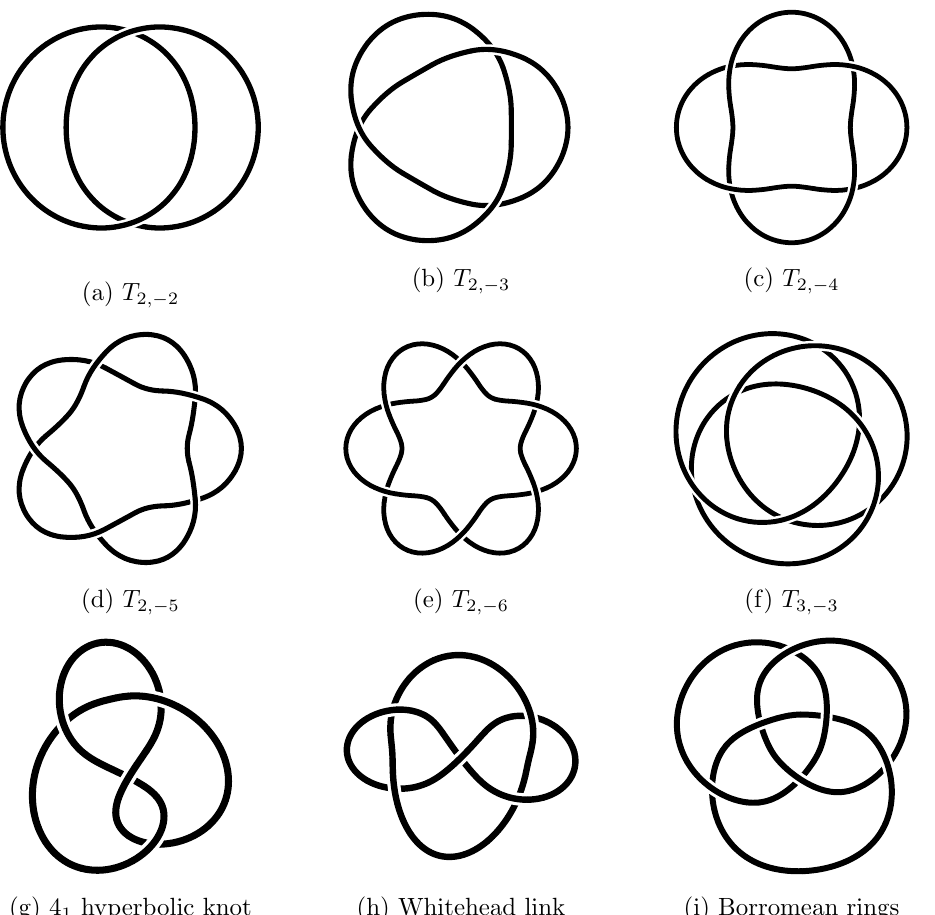
Figure 2. A list of basic knots and links. In the (cid:12)rst two rows we list the (cid:12)rst several torus knots and links. In the third row we give examples of non-torus knot and links. Here the orientation of the links are chosen such that the right most (two for (a), (c), (e) and (h), three for (f) and (i)) vertical strands are oriented